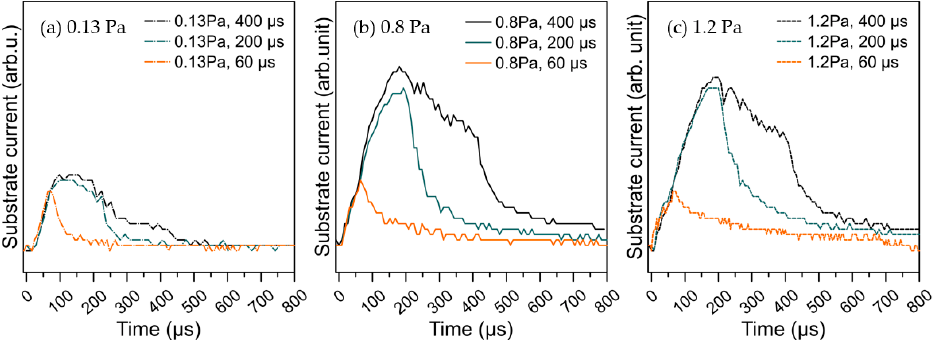
Coatings 2021 , 11 , x FOR PEER REVIEW Figure 1. The single current pulse waveforms of the rectangular pulse voltages with different pulse widths for high-power impulse magnetron sputtering (HiPIMS) discharges on a Zr target in argon at ( a ) 0.13 Pa ( b ) 0.8 Pa and ( c ) 1.2 Pa.